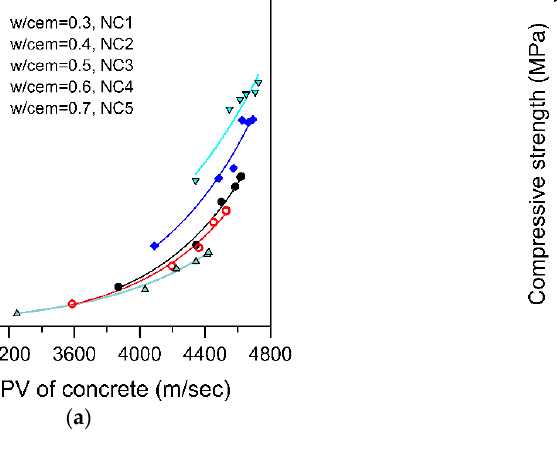
Figure 2. Relationship of UPV and strength in normal concrete: ( a ) regression based on water-to- cementitious-material ratio; ( b ) regression based on the specimen age.